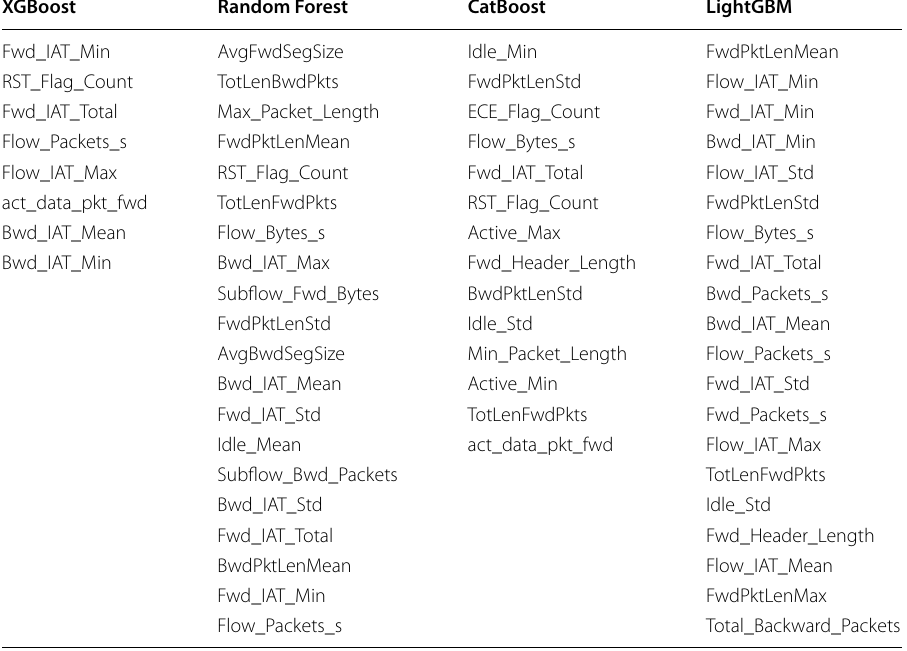
Table 15 Top 20 features for Brute Force web attacks ranked by Supervised-based Feature Importance